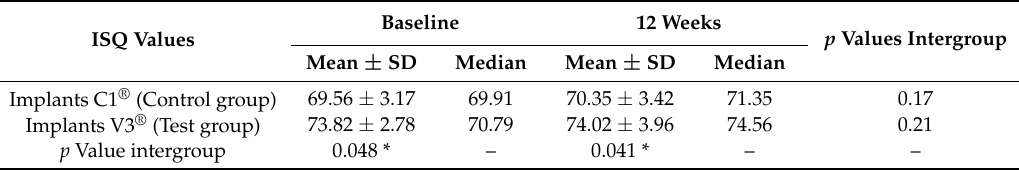
Table 1. ISQ analysis and measurements at baseline and 12 weeks. Results presented as mean values and medians. A Friedman test was applied for inter-group comparisons. ( p < 0.05); * indicates statistically significant differences (<0.05).